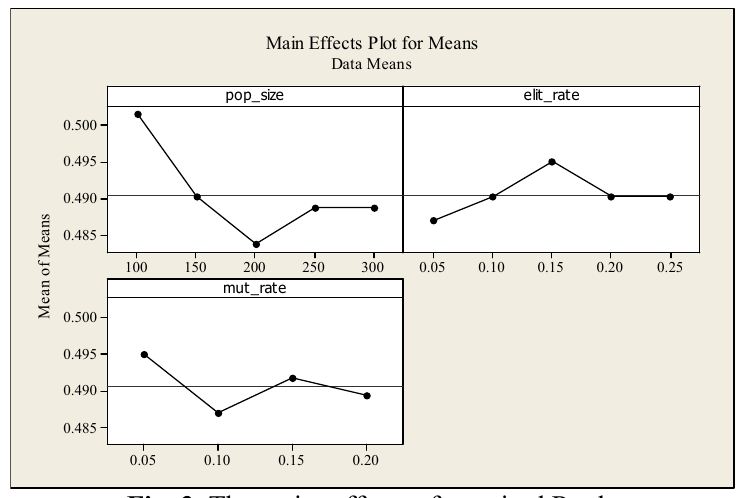
Fig. 3. The major effects of unpaired Reply